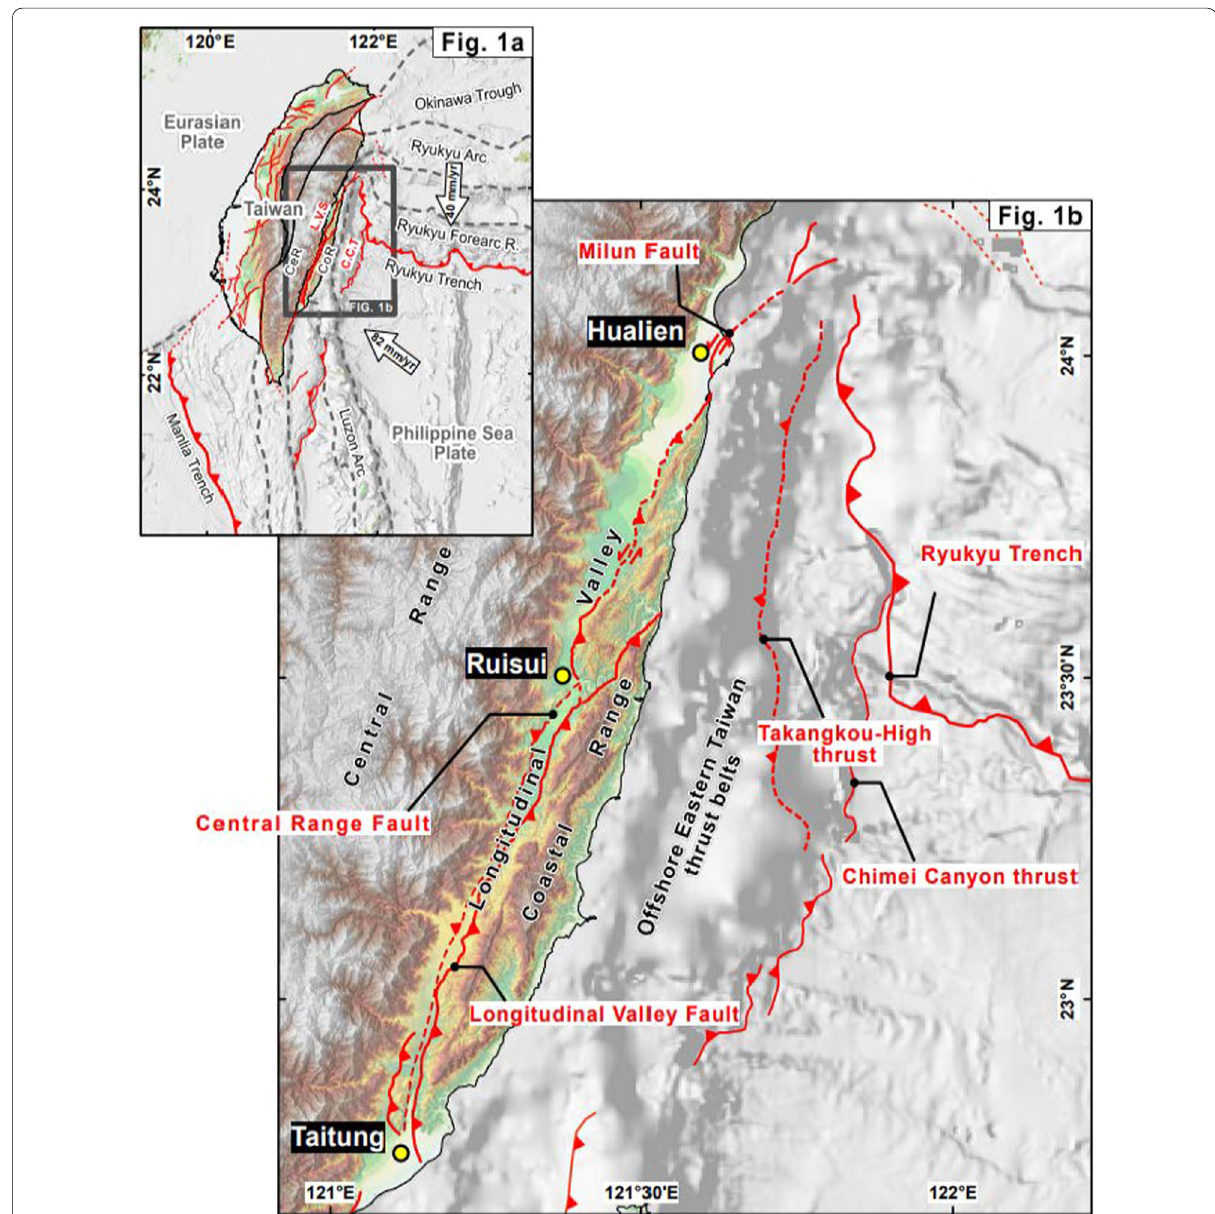
Fig. 1 General tectonic map of Taiwan showing major active tectonic elements near Eastern Taiwan. a Eastern Taiwan is experiencing tectonic collisions between the volcanic arc (Coastal Range/Luzon arc) and the basement‑involved accretionary wedge (Central Range) at the western edge of the Philippine Sea Plate. More than half of the active convergence between the Philippine Sea Plate and the Eurasian Plate is absorbed by the Longitudinal Valley Suture system (LVS) and its associated structure. In the north, both the coastal range and the Longitudinal Valley Suture intersects to the Ryukyu Trench, with the Okinawa Trough and Ryukyu Forearc Ridge formed above the Ryukyu subduction zone. The opening and tectonic rotation near the LVS‑Ryukyu trench junction enhance the N–S convergence along the Ryukyu Trench. b Active tectonic map along the Longitudinal Valley shows three major structures from the base of the Central Range to the offshore eastern coast. These structures on the surface include the Central Range Fault, The Longitudinal Valley Fault, and the Chimei Canyon Thrust as the deformation front of the Offshore Eastern Taiwan Thrust Belt (Active fault map is modified from Shyu et al. (2005a, b), Shyu et al. (2020), velocity of PSP is from Yu et al. (1997); the velocity of Ryukyu Arc is from Lallemand and Liu